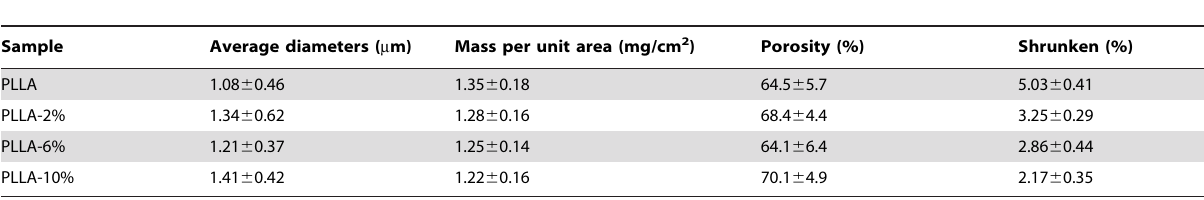
Table 1. Characteristics of electrospun PLLA fibrous scaffolds with G-Rg3 (n= 3).